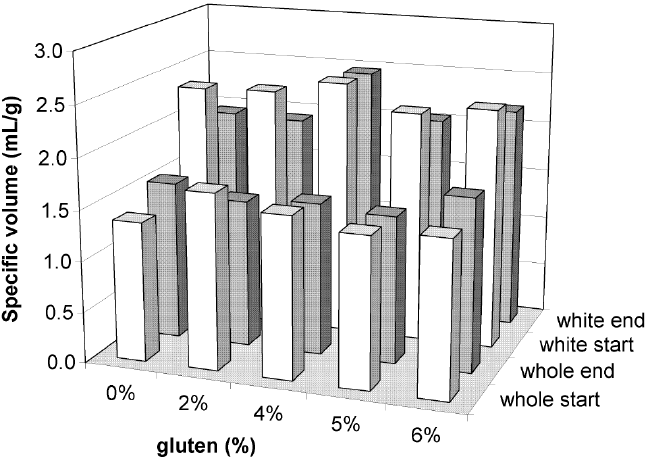
Figure 1. Weight loss (%) during baking of bread samples made from white (start = 11 days, end = 111 days) and whole wheat flour (start = 10 days, end = 110 days).